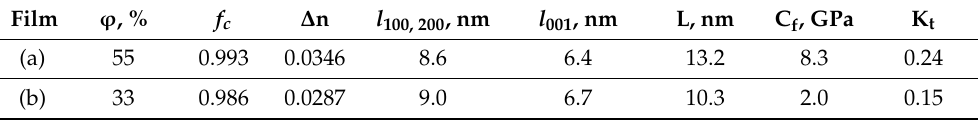
Table 2. Characteristics of textured PVDF films obtained by solid-state gel extrusion (a) and uniaxial drawing with isometric annealing of a sample crystallized from the melt (b)